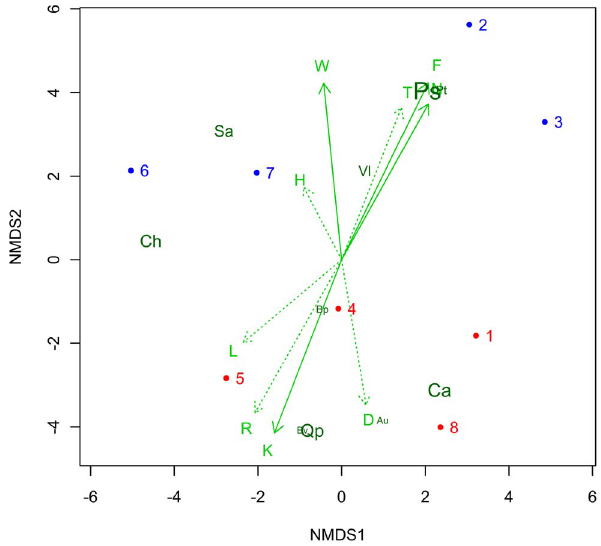
Figure 3. Non-metric multidimensional scaling (NMDS) of the eight plots after nine year of irrigation of the ten most abundant plant species (control=red dots, Irrigated=blue dots). The plant species are plotted with logarithmic abundance indicated by font size and orientation of their highest abundance in the plots indicated by the arrows (dark green; Ps= Pinus sylvestris , Ca= Carex alba , Qp= Quercus pubescens , Ch= Carex humilis , Sa= Sorbus aria , Vl= Viburnum lantana , Pt= Populus tremula , Bp= Betula pendula , Au= Arctostaphylos uva-ursi , Bv= Berberis vulgaris ). The Landolt indicator values are fitted to the plot (light green arrows; significant= solid; non-significant= dotted) for the following properties: D (aeration value), F (moisture value), H (humus value), K (continentality value), L (light value), N (nutrient value), R (reaction value (pH)), T (temperature value), and W (moisture variability value).